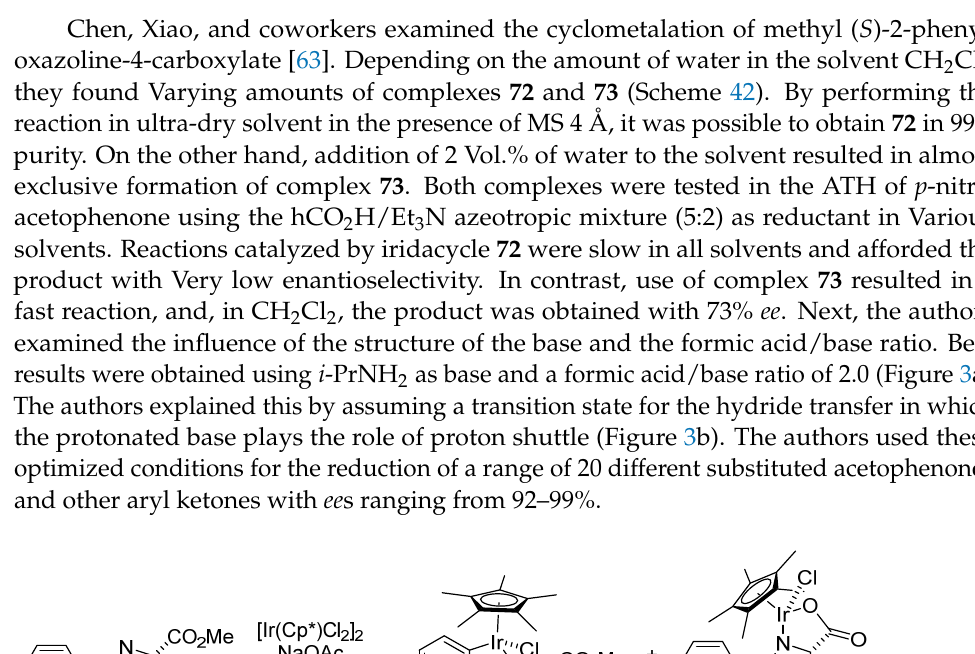
Figure 1. ( a ) Effect of the structure of base and the formic acid/base ratio on the enantioselectivity of the ATH of p -nitro-acetophenone catalyzed by 73 . ( b ) Proposal for the transition state of the hy- dride transfer ( a ), reprinted with permission from [63]; copyright 2018 American Chemical Society. Baya, Mata, and coworkers prepared two NHC-ligated iridacycles 74a and 74 b via reaction of Ir(Cp*)(NHC)Cl 2 with ( R )-1-naphth-1-yl-ethylamine under the influence of AgOAc and KPF 6 [64]. After treatment with base, which presumably deprotonates the amine group to from the amide complex. These complexes were active as ATH catalysts. A small set of four aromatic and one aliphatic ketone was reduced to the alcohols with ee s between 2% and 58% (Scheme 43). This activity is somewhat surprising as no ligand po- sition is available for the formation of a hydride. On the basis of DFT calculations, the authors proposed a Meerwein–Ponndorf–Verley type mechanism in which the amide group deprotonates isopropanol, which transfers its hydride to the ketone, which is pro- tonated by the remaining proton of the amide ligand. The proposed transition state is de- picted in Figure 2.